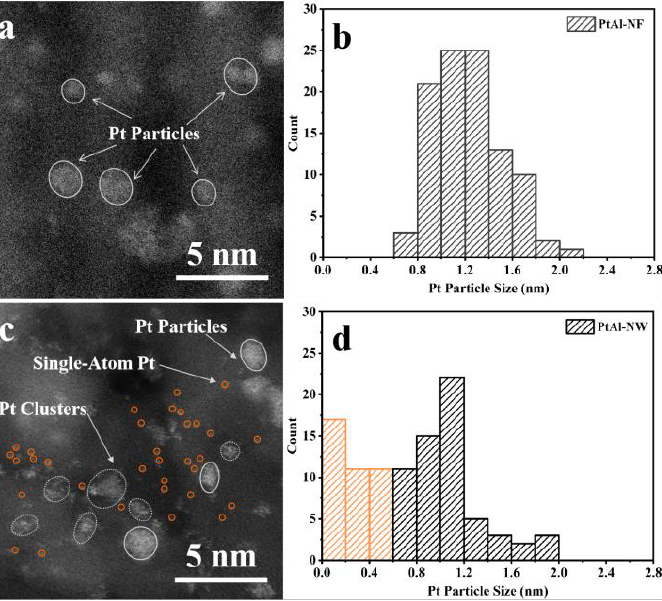
Figure 8. HAADF-STEM images of ( a ) PtAl-NF and ( c ) PtAl-NW; Pt particle size distribution of ( b ) PtAl-NF and ( d ) PtAl-NW. The count number of Pt particles on each sample was 100. The IR spectra were collected in a reaction mixture of 0.07 vol. % C 2 H 4 and 20 vol. % O 2 from 120 °C to 180 °C on PtAl-NF and PtAl-NW catalysts. The Pt surface could only exist in two stable states: CO-covered (inactive) or O-covered (active), hence the limiting step mostly prevented the C 2 H 4 oxidation (reaction R9 in Table 2). Pt agglomerates with